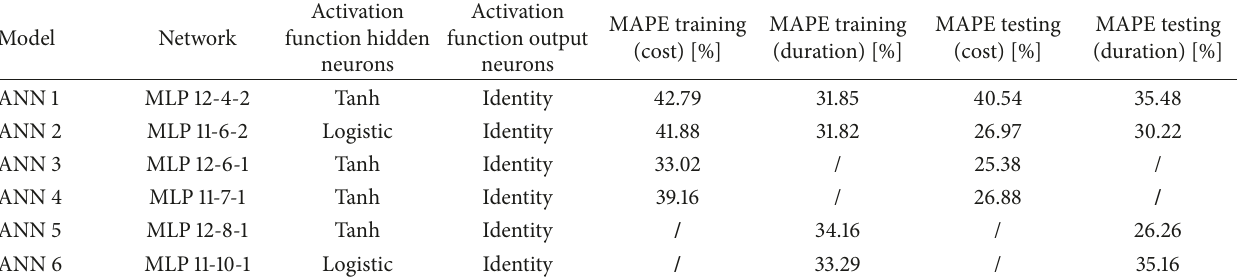
Table 7: ANN models (min-max).